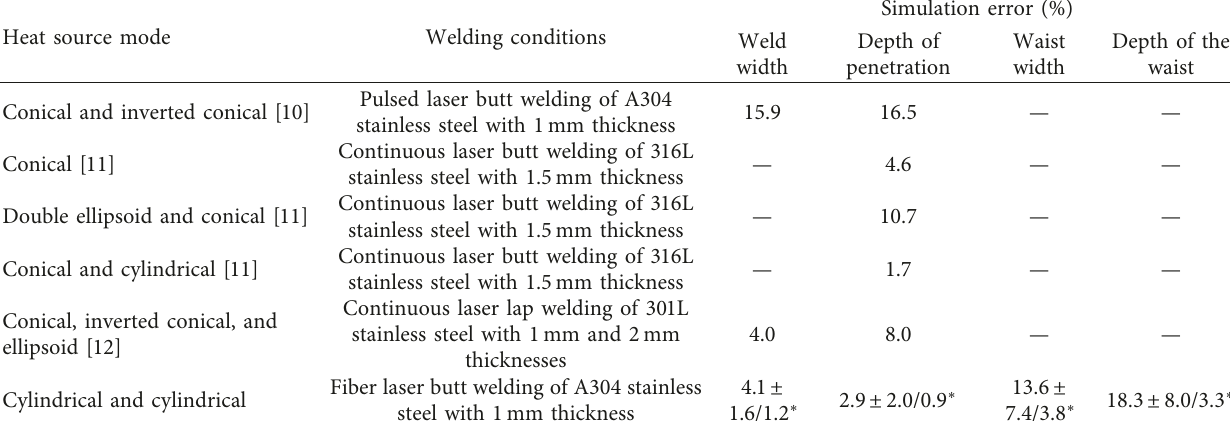
Depth of the width waist